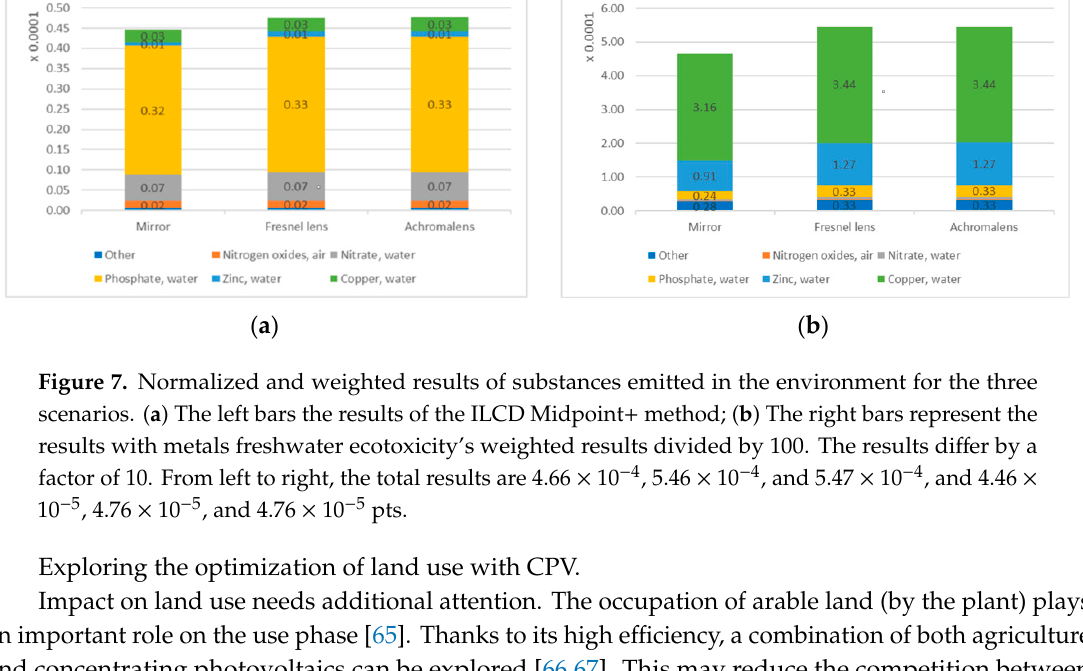
Table 3. Environmental impact assessment results for 1 kWh stemming from different energy sources. The first three categories are obtained with the ILCD Midpoint+ 2011 method and the last one with the Cumulative Energy Demand version 1.0.9 [69] method. ES, SE, PL, and CN represent, respectively, Spain, Sweden, Poland, and China. Impact of fossil resources are calculated using the EcoInvent database [70]. Category Unit